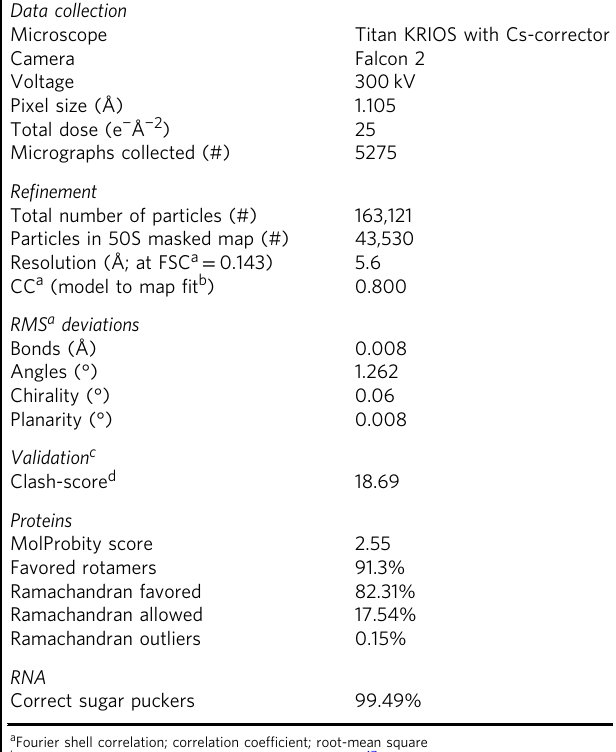
Table 1 Data collection, re fi nement, and validation statistics Data collection